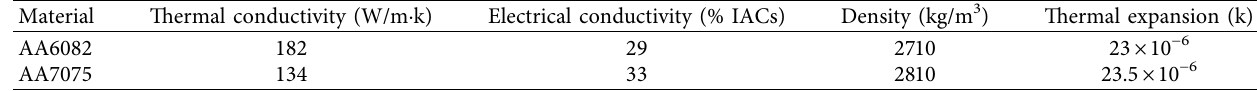
Table 2: Physical properties of base material alloys [16, 17].